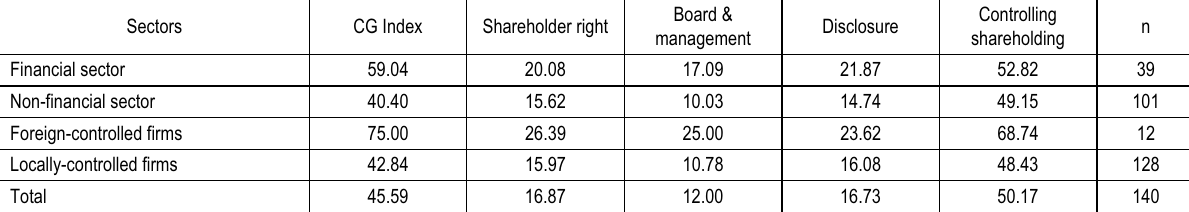
Table 1. Mean values of corporate governance index across the sample firms